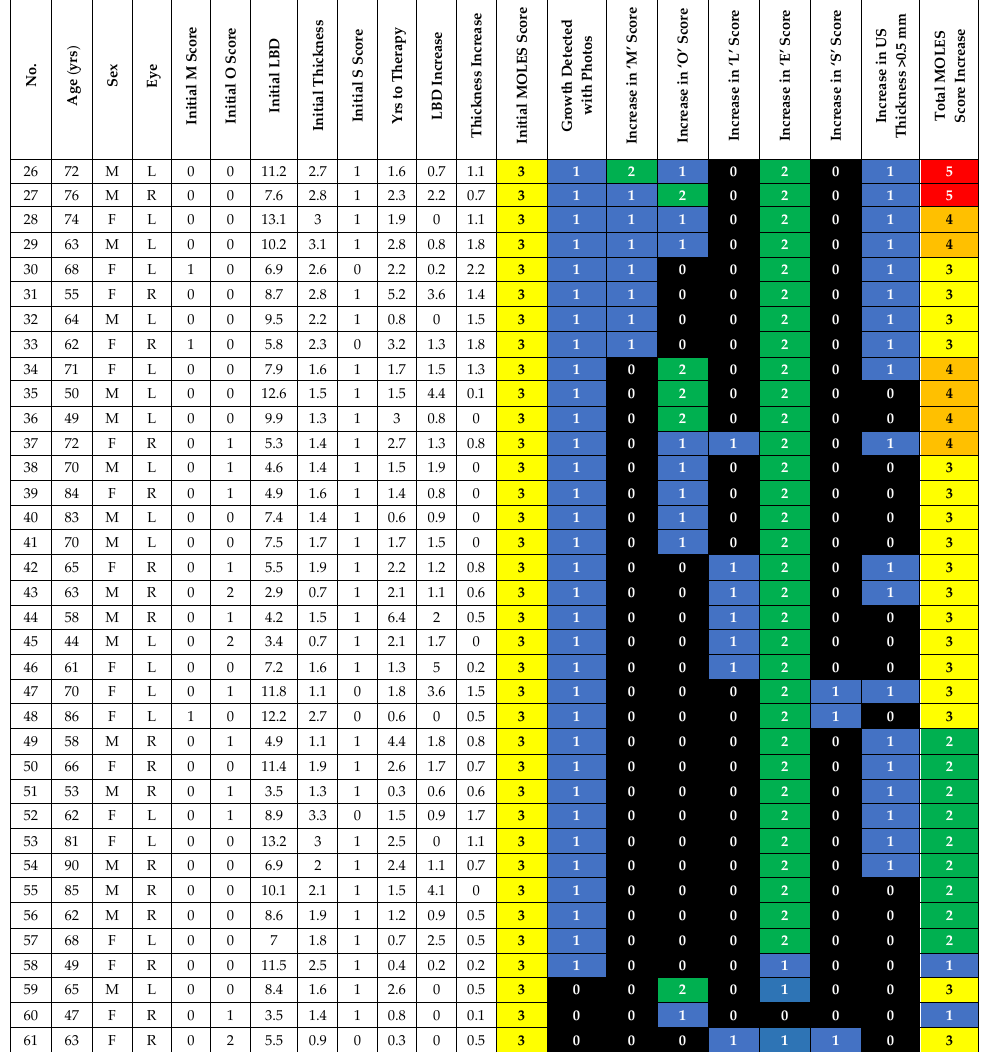
Figure 2. Demographic, baseline and progression details of MOLES 3 cases.